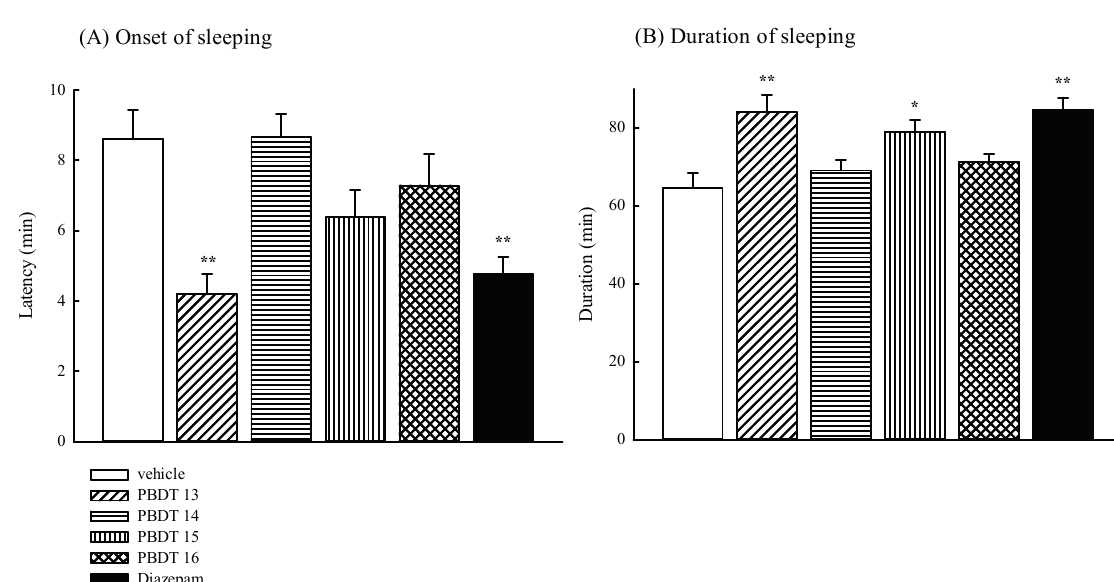
Figure 2. The effects of PBDTs 13 – 16 (1 mg/kg, ip) or diazepam (1 mg/kg, ip) on the ( A ) the latency to the loss of righting reflex and ( B ) total duration of sleeping time induced by sodium pentobarbital (30 mg/kg, ip). Values are the mean ± SEM, n = 4 mice; * p < 0.05, ** p < 0.01, compared with the vehicle